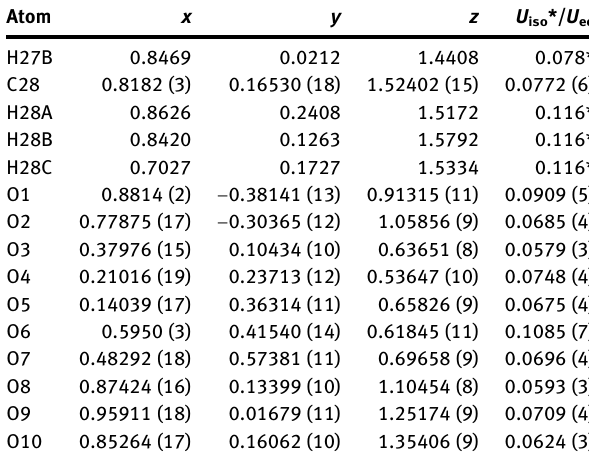
Table  : Fractional atomic coordinates and isotropic or equivalent isotropic displacement parameters (Å 